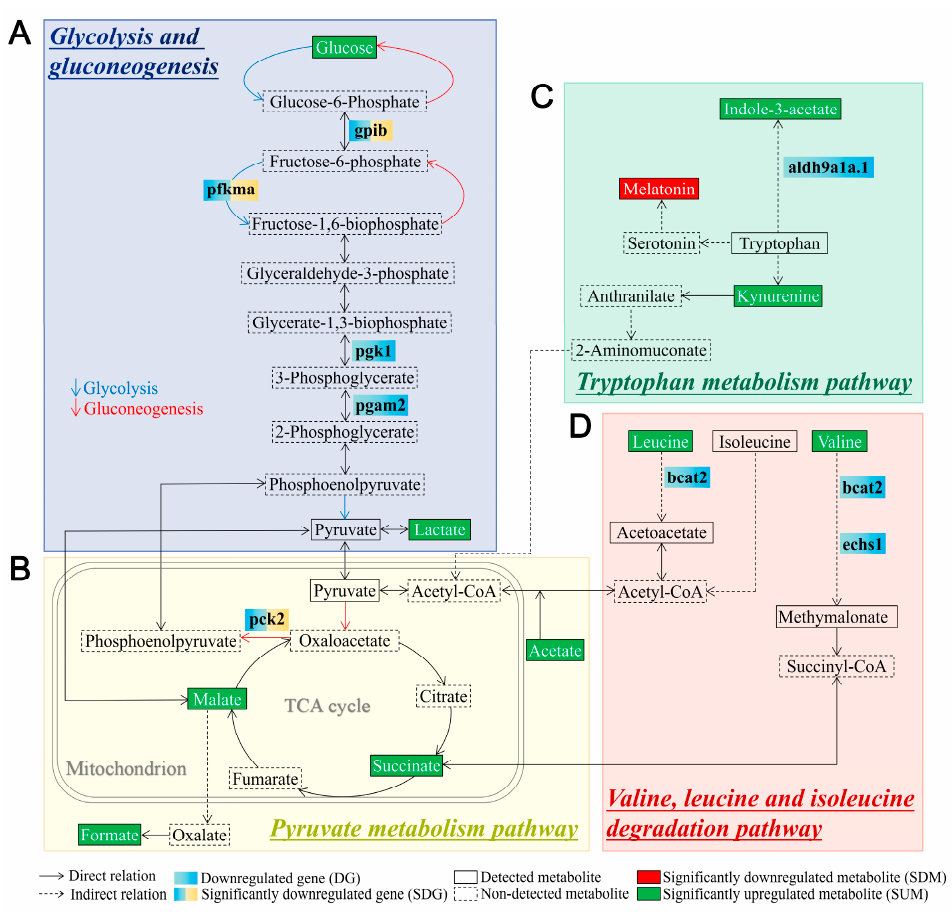
Figure 7. Schematic diagram of differentially expressed metabolites and genes in the significantly enriched signaling pathways associated with metabolism in tlr2 mutant zebrafish larvae compared to wild type control. ( A ) Glycolysis and gluconeogenesis pathway. ( B ) Pyruvate metabolism pathway. ( C ) Tryptophan metabolism pathway. ( D ) Valine, leucine, and isoleucine degradation pathway. The notes for each icon in the diagram are at the bottom of the diagram. For RNAseq data, setting the S value ≤ 0.005 as the cutoff to find significantly expressed genes. For NMR data, significance was established at p < 0.05. The genes shown in blue boxes are non-significant downregulated genes in tlr2 mutant larvae (log2 fold change level and S value of pgk1 is -0.59 and 0.022, pgam2 : − 0.50, 0.061, aldh9a1a.1 : − 0.56, 0.014, bcat2 : − 0.45, 0.089, echs1 : − 0.73, 0.024. Table S2).